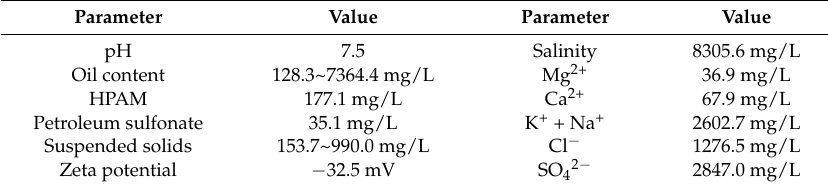
Figure 3. Performance of demulsifiers in treating EOR PW from the Xinjiang Oilfield. Oil content in PW, 358.5 mg/L. Dose of demulsifiers, 500 mg/L. Temperature, 40 °C. Table 1. Characteristics of produced water from HPAM/petroleum sulfonate flooding in the Xinjiang Oilfield.